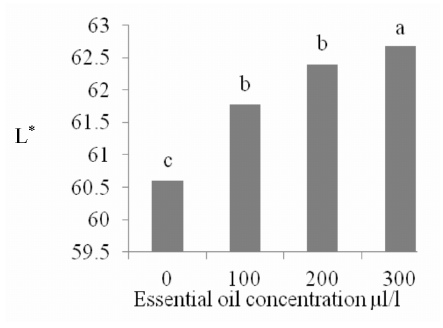
Fig. 7. The effect of basil essential oil treatment on TAA of ‘Golden Drop’ plum